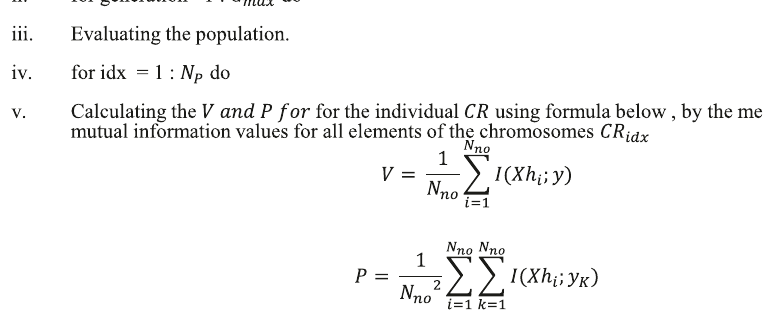
Figure 4: The information theory algorithm